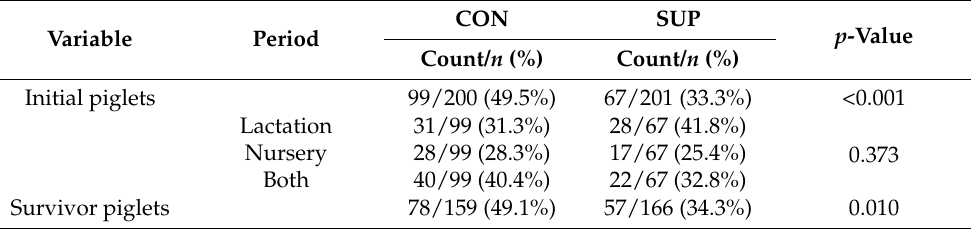
Table 6. Percentages of injectable antibiotic treatment in the CON and SUP groups. Data are count/ n ; percentages are shown in brackets. CON: control group; SUP: colostrum supplemented group. Comparisons between groups were made by using Pearson’s Chi-squared test.